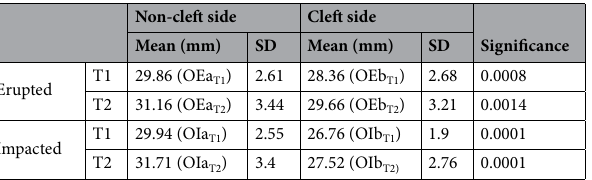
Table 3. Distance between the origin and the canine of non-cleft side and cleft side at T1 and T2.